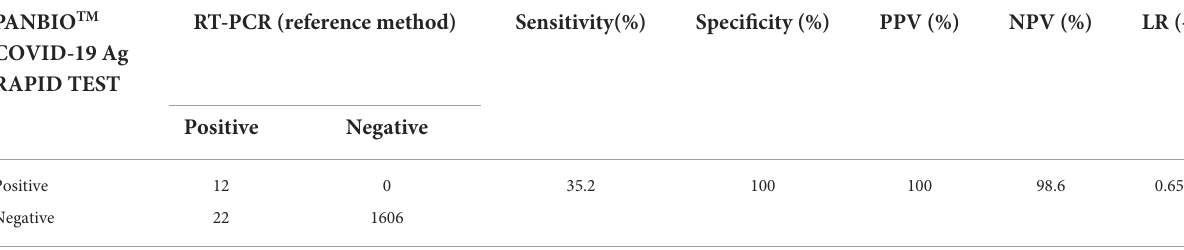
TABLE 4 Comparison between RT-PCR performance (reference method) and PANBIO COVID-19 Ag Rapid test. PANBIO